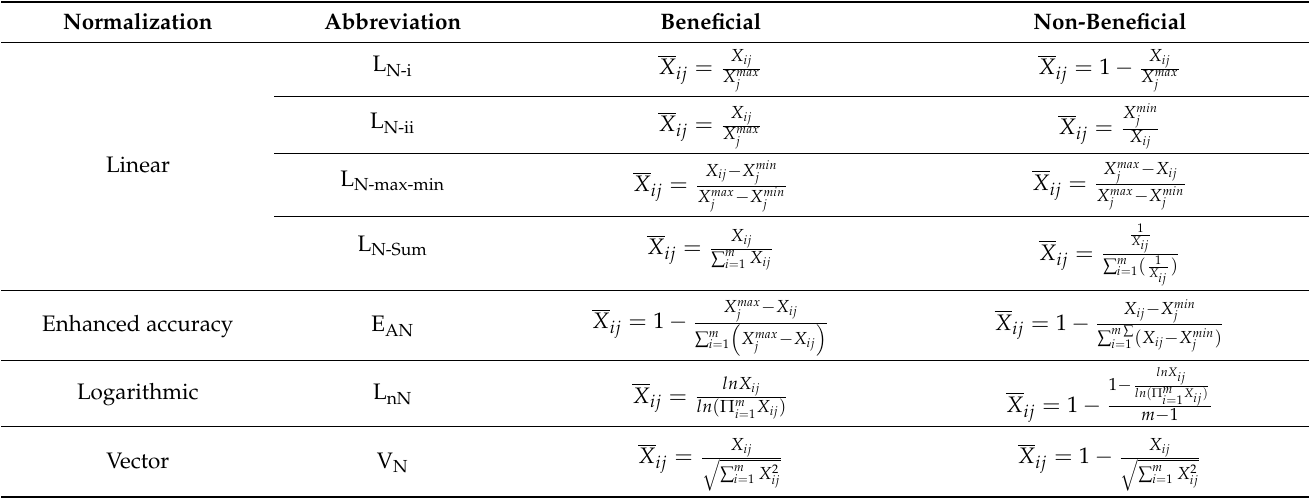
Table 2. Mathematical formulas of different normalization methods.